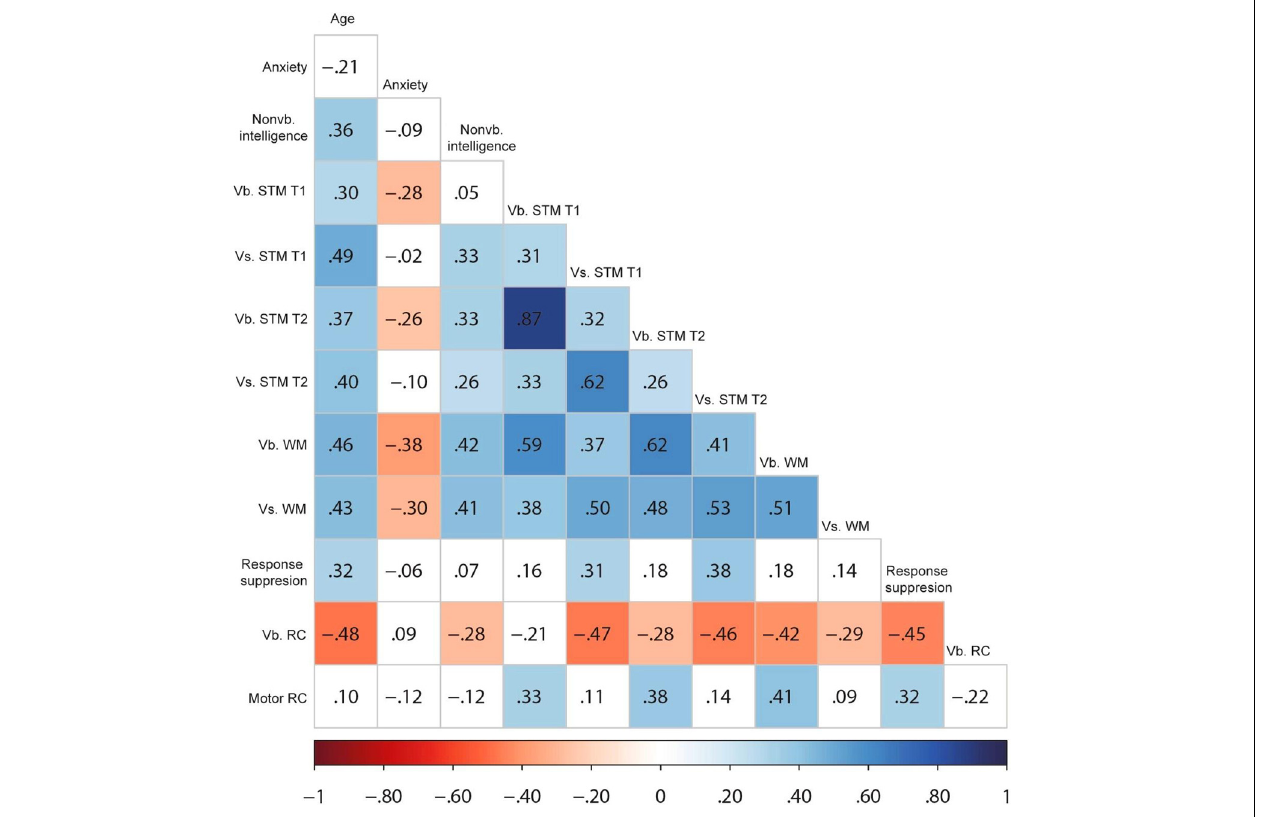
FIGURE 2 | Pearson bivariate correlation matrix for the measures of interest. Color saturation represents the correlation strength according to the scale below the figure. Vb., verbal; Vs., visuospatial; STM, short-term memory; WM, working memory; RC, Response conflict.